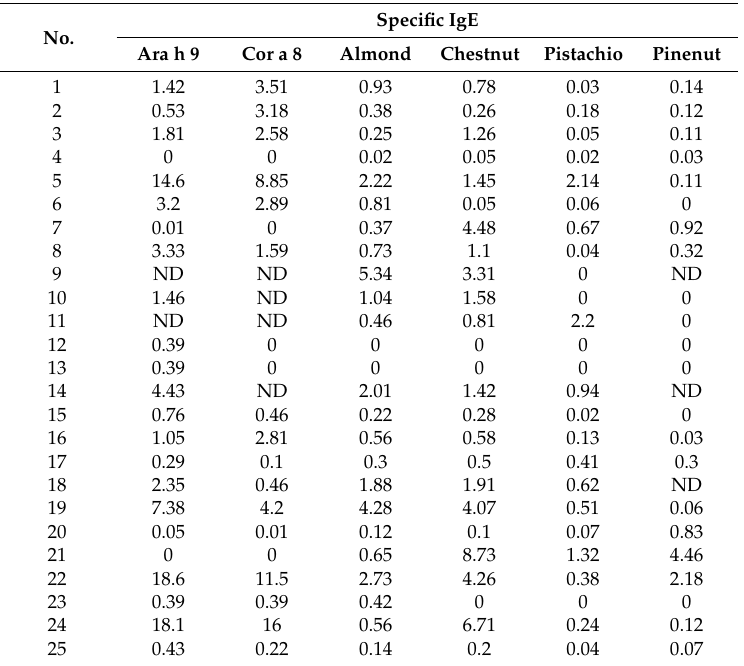
Table 2. Nut allergic patients from